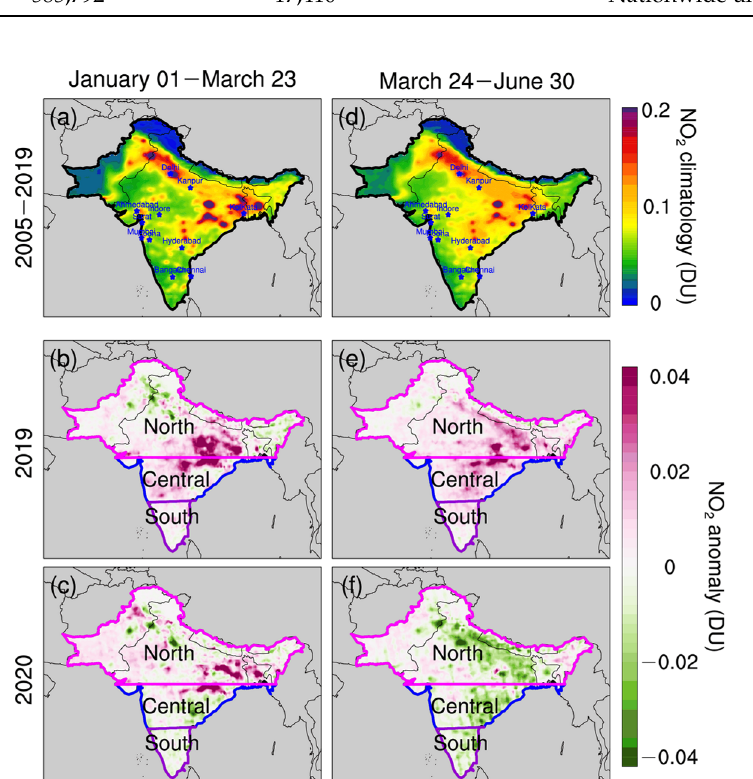
Figure 1. Column abundance of tropospheric NO 2 climatology (2005–2019) and anomaly (2019 and 2020). ( a – c ): pre-lockdown period and ( d – f ): lockdown period. The anomaly is defined as the devi-